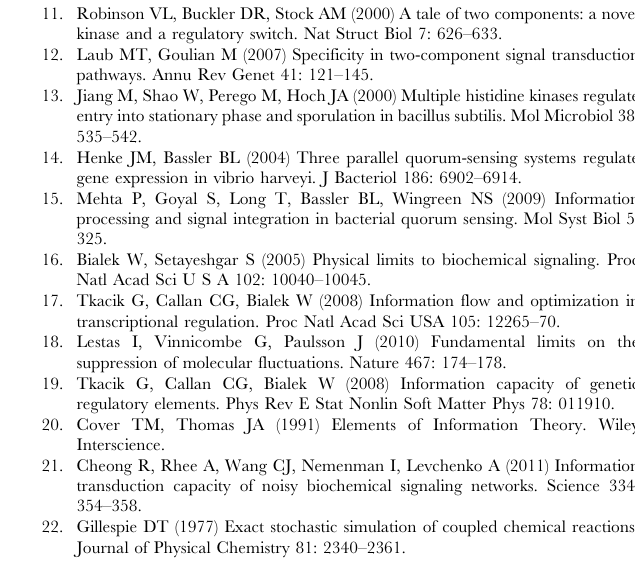
respectively. The z-axis is the average maximum accumulation of the output, phosphorylated RSmad. Figure S4 Dynamic Range of Maximal R-Smad Accu- mulation for Unilateral Fold Changes of K x K y and d R 1 d R 2 . This figure demonstrates the effect of asymmetrically varying the rates of receptor degradation and ligand binding. Note that the panels become skewed as the rates are increased/ decreased asymmetrically for X and Y. The x- and y-axes correspond to the initial ligand amount of ligand X and Y respectively. The z-axis is the average maximum accumulation of the output, phosphorylated RSmad. Figure S5 Effect of the Ligand On rate, K x , K y on information transfer. The ligand on rate was increased or decreased 10-fold and 1000-fold and tested across a range of cross- talk values. Figure S6 Effect of the Ligand Off rate, d x , d y on information transfer. The ligand off rate was increased or decreased 10-fold and 1000-fold and tested across a range of cross- talk values. Figure S7 Effect of the Ligand On rate, K x , K y on information transfer. The ligand on rate was increased or decreased 10-fold and 1000-fold and tested across a range of cross- talk values. Figure S8 Effect of the Ligand Off rate, d x , d y on information transfer. The ligand off rate was increased or decreased 10-fold and 1000-fold and tested across a range of cross- talk values. Figure S9 The Dynamic Range of the Large Two- Component Model. Falls within the dynamic range of the small smad model.